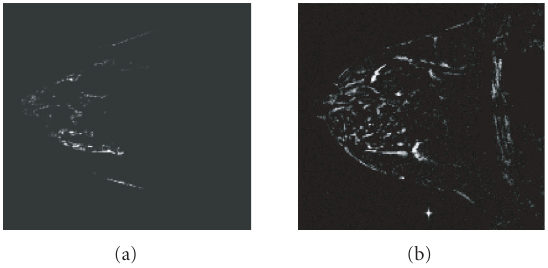
Figure 6: Extracted glandular tissue: (a) using the deformable sheet-curve model, and (b) using TPS with feature points alone.